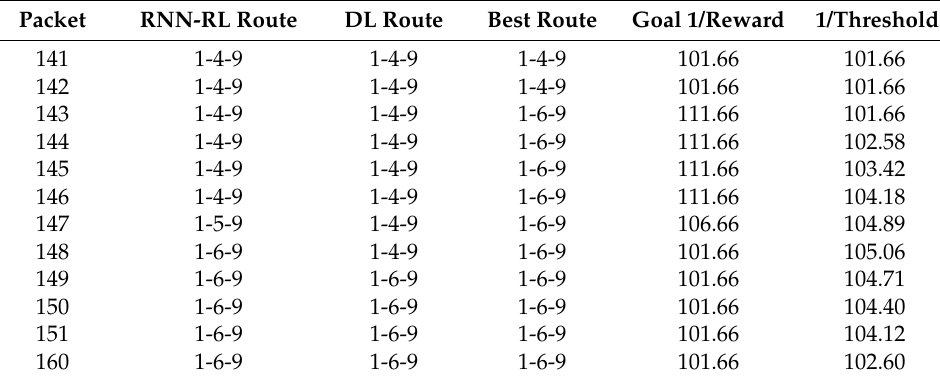
Table 8. Goal: 0.3 × Delay + 0.3 × Loss + 0.3 × Bandwidth (3 × 3